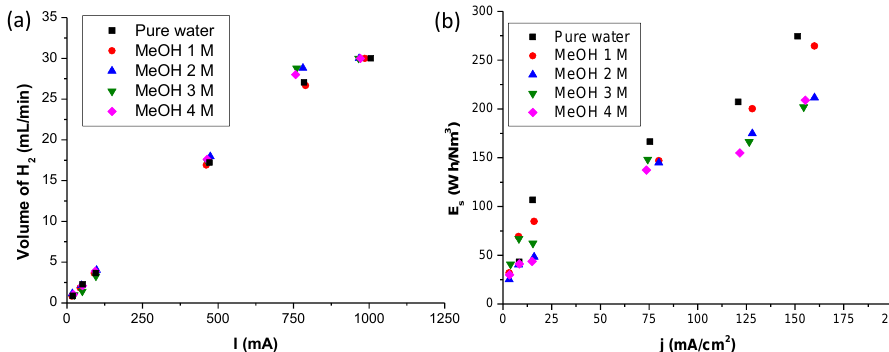
Figure 6. ( a ) Volume of hydrogen obtained versus provided current for each methanol (MeOH) concentration and pure water solution. ( b ) Comparison of electrical energy needed to produce hydrogen in electrolysis by methanol–water solution at different methanol (MeOH) concentrations and in pure water.